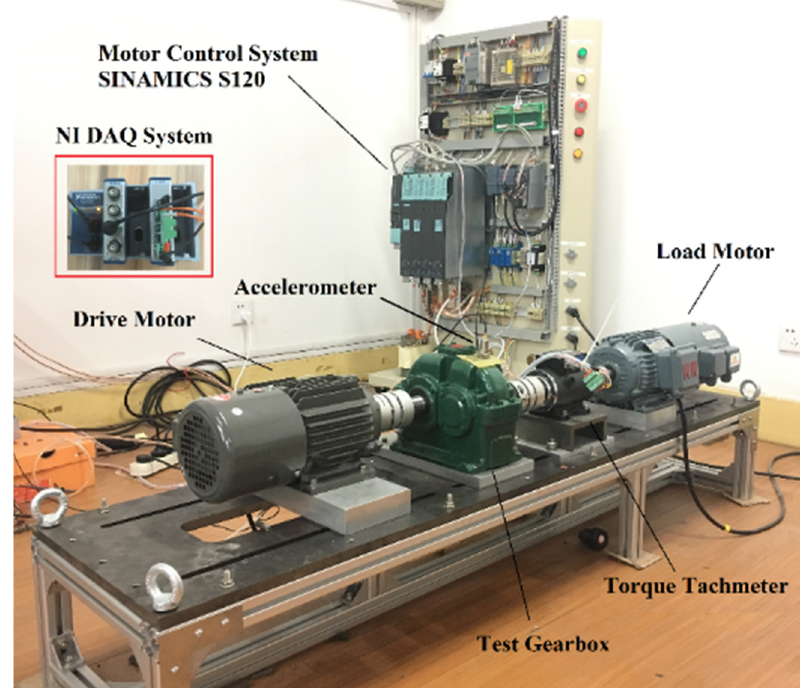
Figure 2. Experimental setup for trials.